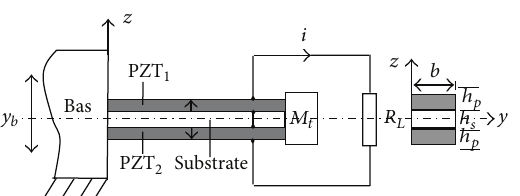
Figure 1: Cantilevered piezoelectric energy harvester excited by the motion of its base in the transverse direction.